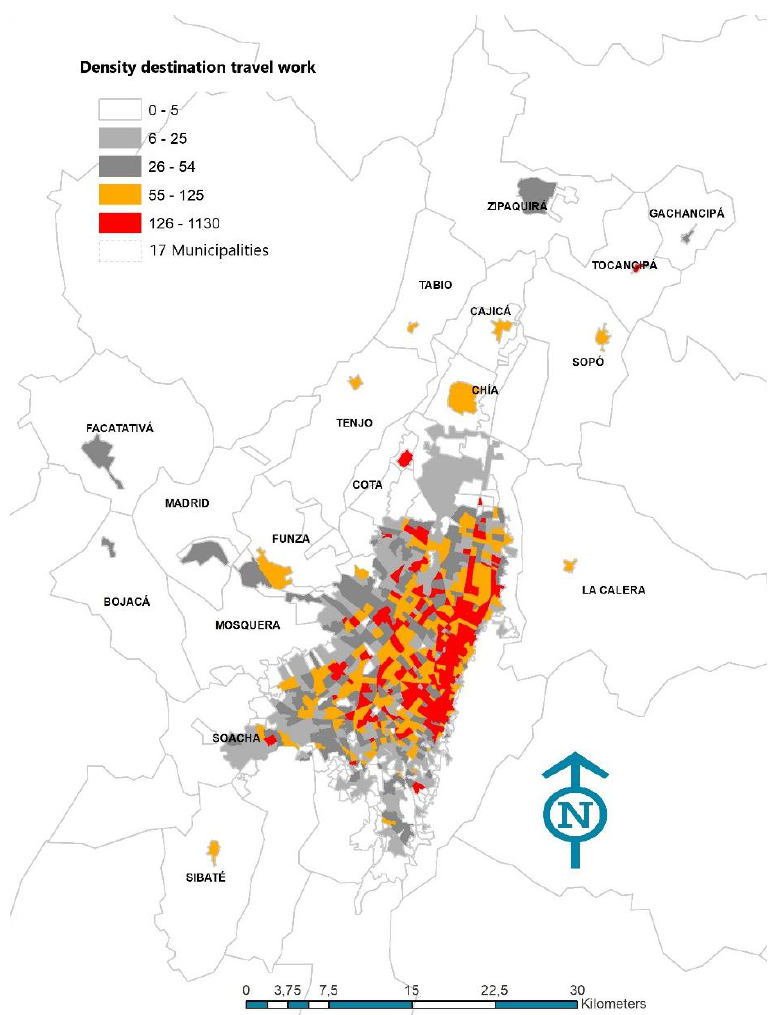
Figure A1. Density of trips to work per hectare. Source: Calculations made with information from Mobility Survey (2015).